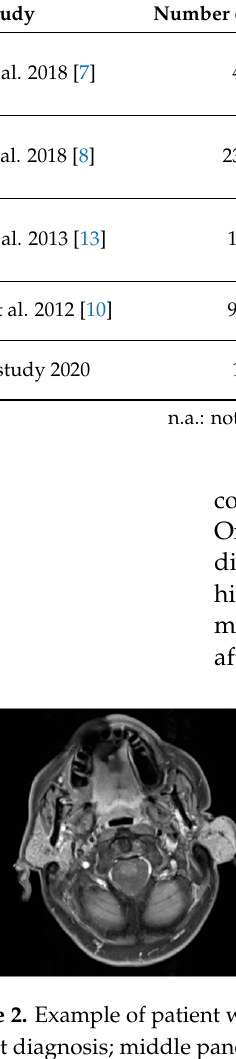
Table 4. Literature overview.